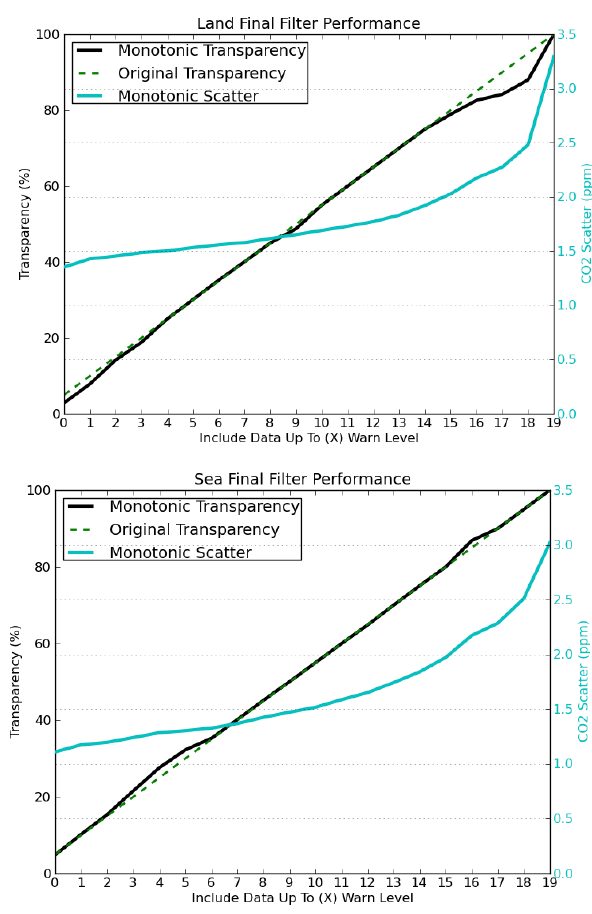
Figure 13. The selector performance for transparency and scatter as a function of inclusive warn levels. Permitting only warn level = 0 data (left of graph) is the most restrictive mode of the filter, while accepting everything up through warn level 19 permits all the data to the right. Note the deviation from original transparency as a function of warn level, caused by enforcing monotonicity of filter thresholds, is very small.